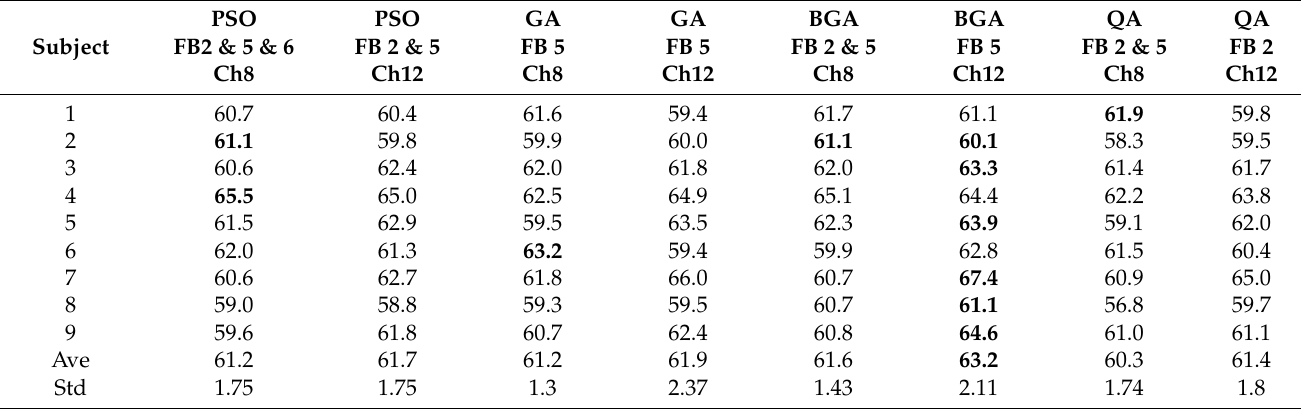
Table 17. The best results of different methods for feature selection (with feature extraction, feature reduction, and channels, etc.) on a single channel 8 or 12 by combining different select bands.